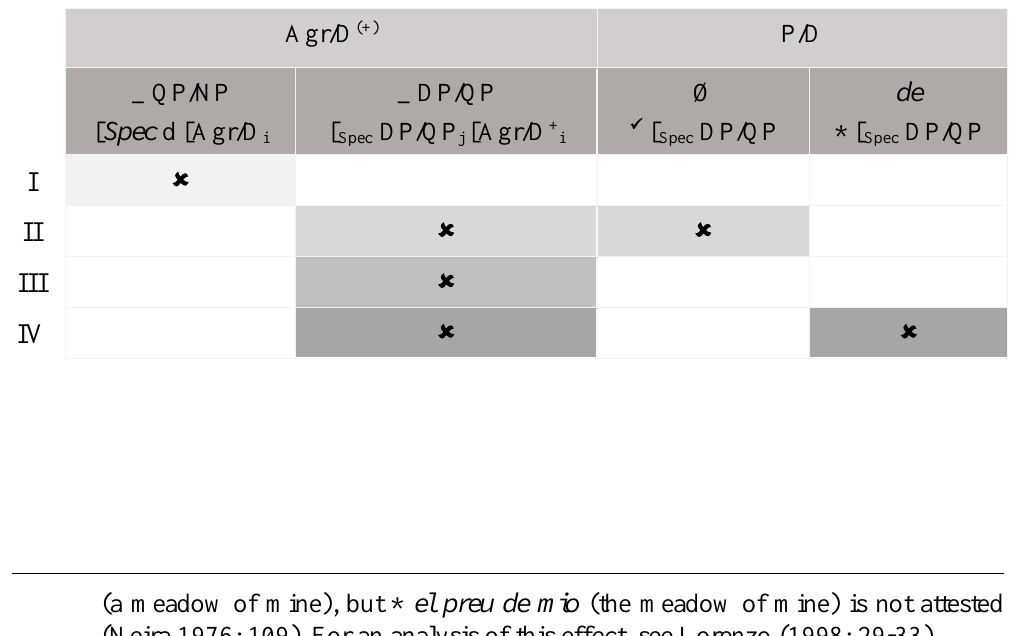
Table 2. Main sources of micro-variation of the Asturian possessive construction types Agr/D